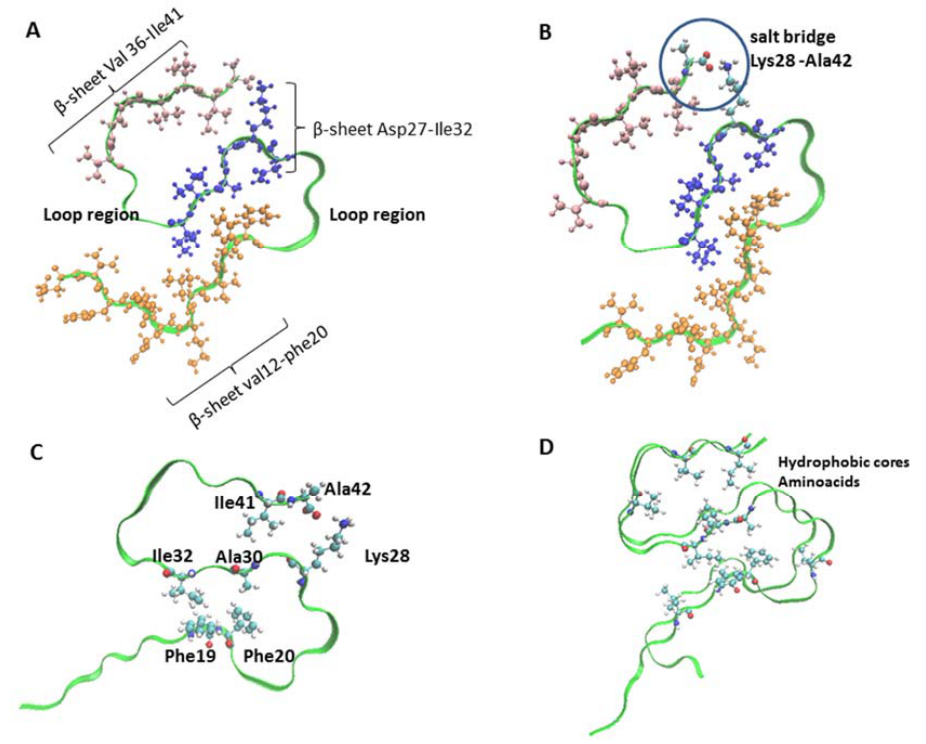
Figure 2. Triple ‐ stranded β‐ sheet indicative of the S ‐ shape fibril structure of A β 1 ‐ 42. ( A ) Val12–Phe20, Asn27–Ile32, and Val36–Ile41 are connected by two loop regions at Ala21–Ser26 and Gly33–Met35. PDB 2MXU; ( B ) salt bridge between Lys28 and Ala42. PDB 2MXU; ( C ) PDB ID: 5KK3; ( D ) Hydrophobic core amino acids in PDB 5KK3 dimer.